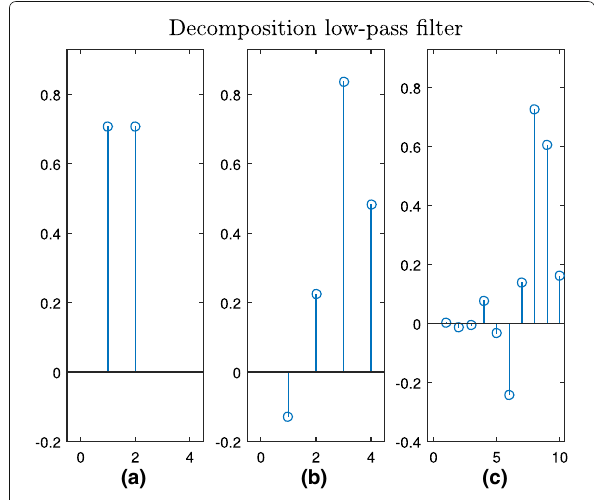
Fig. 4 Low-pass filter parameters of different wavelet families. a Haar, b DB2, c DB5